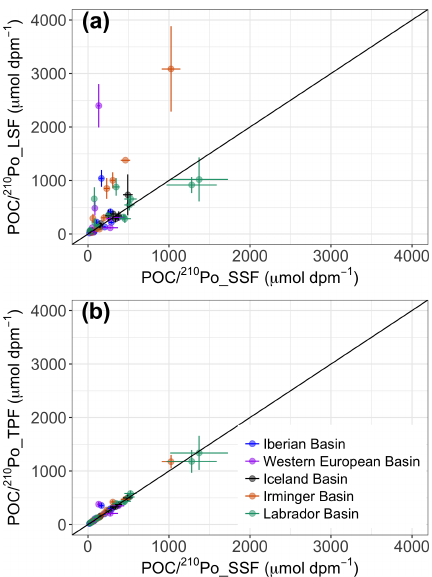
Figure 4. Plots of the ratios of POC concentration to 210 Po activ- ity in (a) the large (>53µm) particles (POC / 210 Po_LSF) against the small (1–53µm) particles (POC / 210 Po_SSF), and in (b) the to- tal (>1µm) particles (POC / 210 Po_TPF) against the small particles. The black lines indicate the 1 : 1